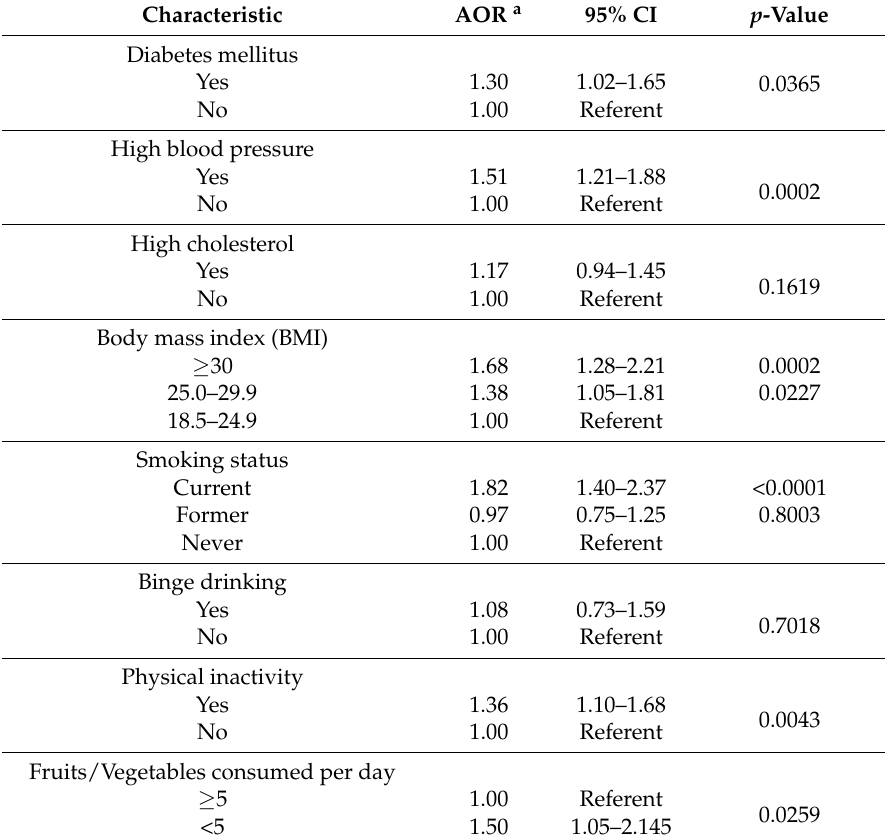
Table 3. Association between food insecurity and select cardiovascular disease risk factors among Mississippi adults, Behavioral Risk Factor Surveillance System,